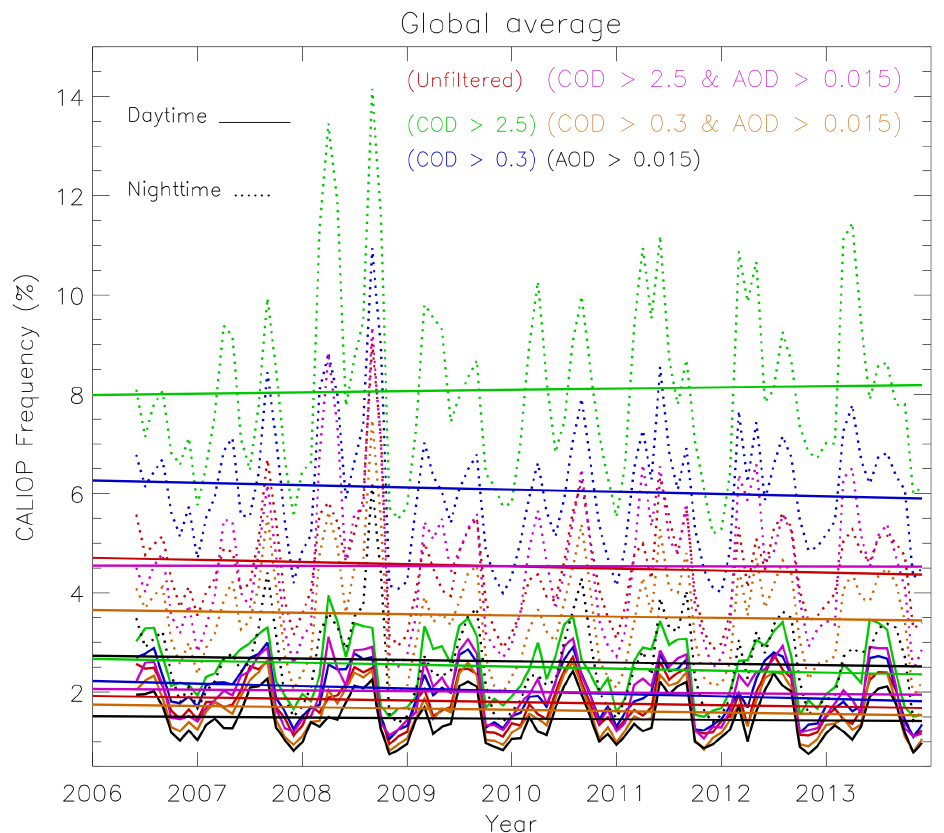
Figure 14. Monthly averaged global CALIOP cloudy-sky frequencies after applying several different threshold techniques to both day- and nighttime data. The solid lines show the daytime scenario for each respective case, while the dotted lines show the nighttime observations for each